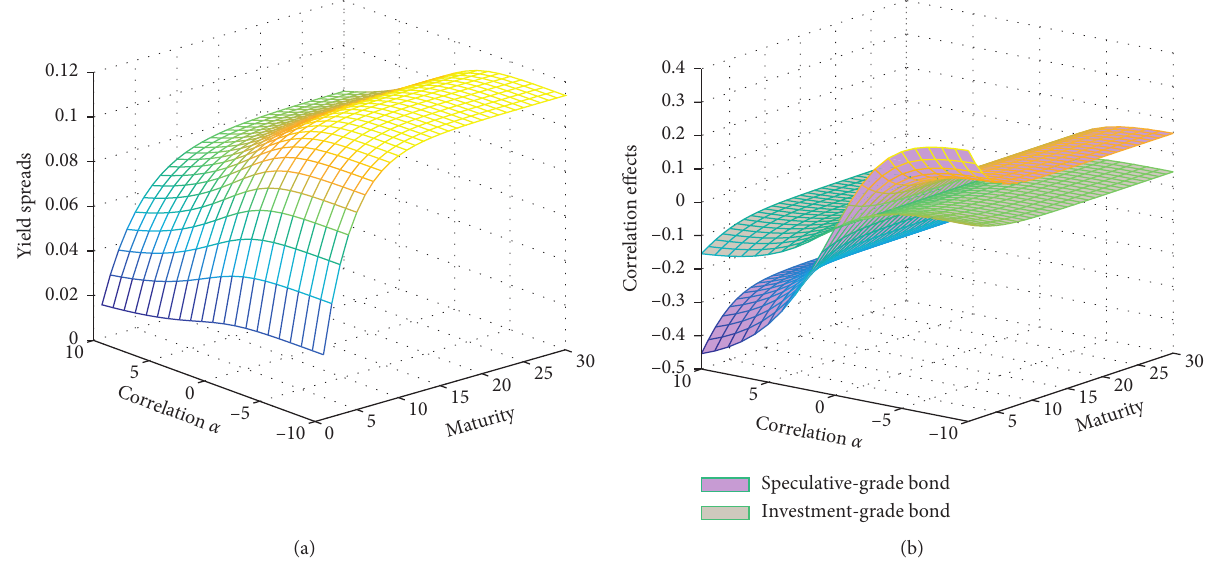
Figure 1: The influence of correlation parameter α on yield